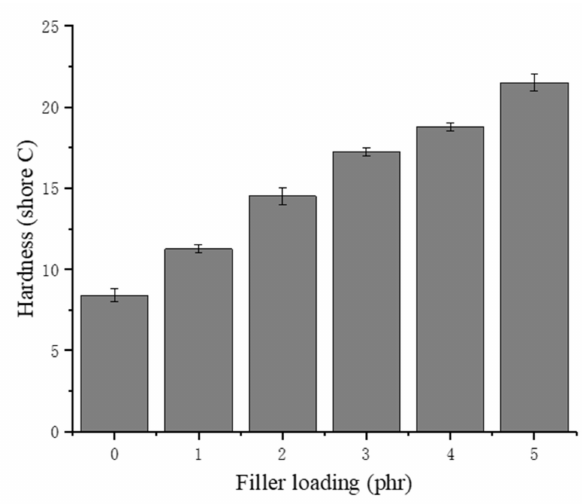
Figure 7. Hardness of chitin–NRLF composites.